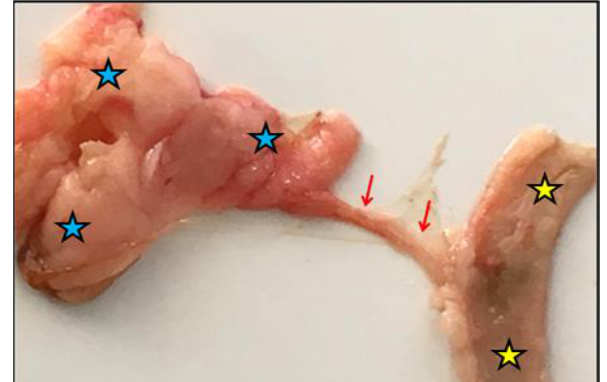
Figure 7. Minor pancreatic duct (red arrows) run through the connecting part of body (blue stars) toward the ascending duodenum (yellow stars).